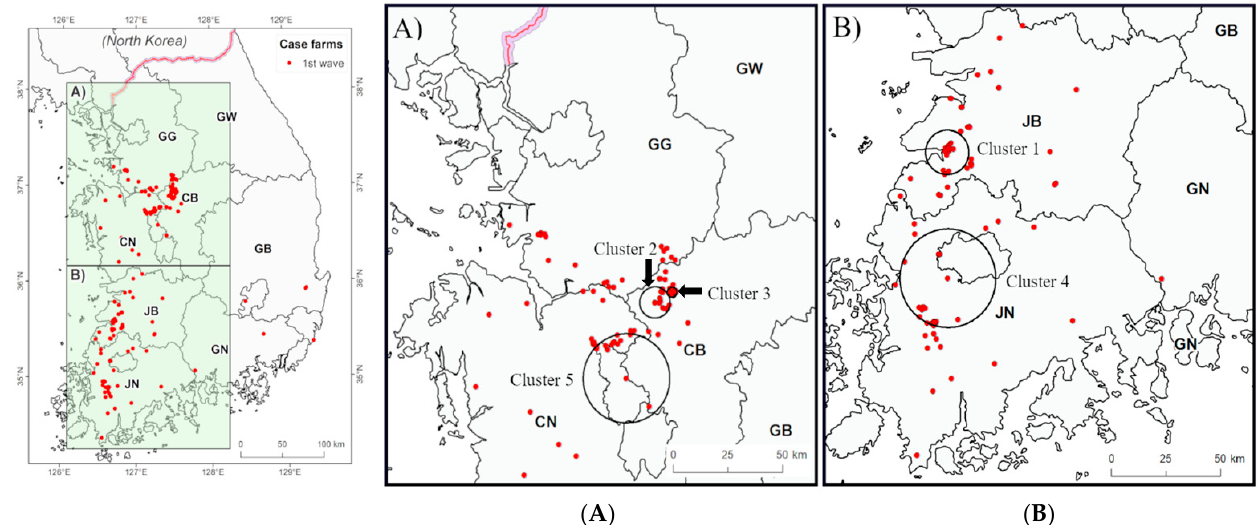
Figure 4. Spatiotemporal cluster of poultry farms during the first wave of HPAI H5N8 outbreaks in Korea. The left map shows whole area of South Korea; ( A ) spatiotemporal cluster of the first wave of HPAI H5N8 in the midwest region; ( B ) spatiotemporal cluster of the first wave of HPAI H5N8 in the southwest region. Red round dots are the outbreaks in poultry farms at the first wave from 14 January 2014 to 29 July 2014. The locations of the clusters are indicated by black circles and clusters name is shown by black arrow. Province abbreviations: CB: Chungbuk, CN: Chungnam, GB: Gyeongbuk, Viruses 2021 , 13 , x FOR PEER REVIEW 8 of 13 GG: Gyeonggi, GN: Gyeongnam, GW: Gangwon, JB: Jeonbuk, JN: Jeonnam.